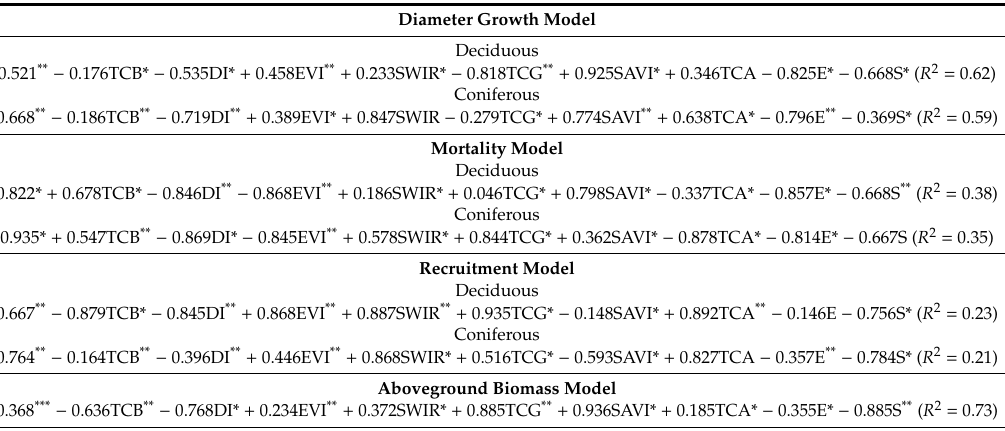
Table 3. Estimated parameters of the diameter growth model, mortality model, recruitment model, and aboveground biomass model in the matrix growth